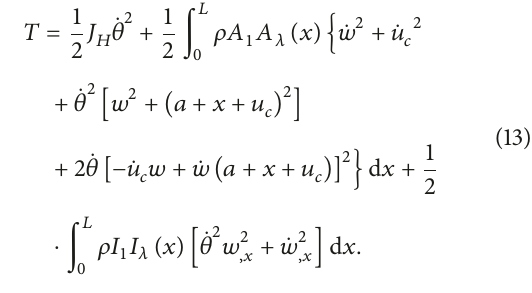
Figure 4: Schematic diagram of the deformation field.